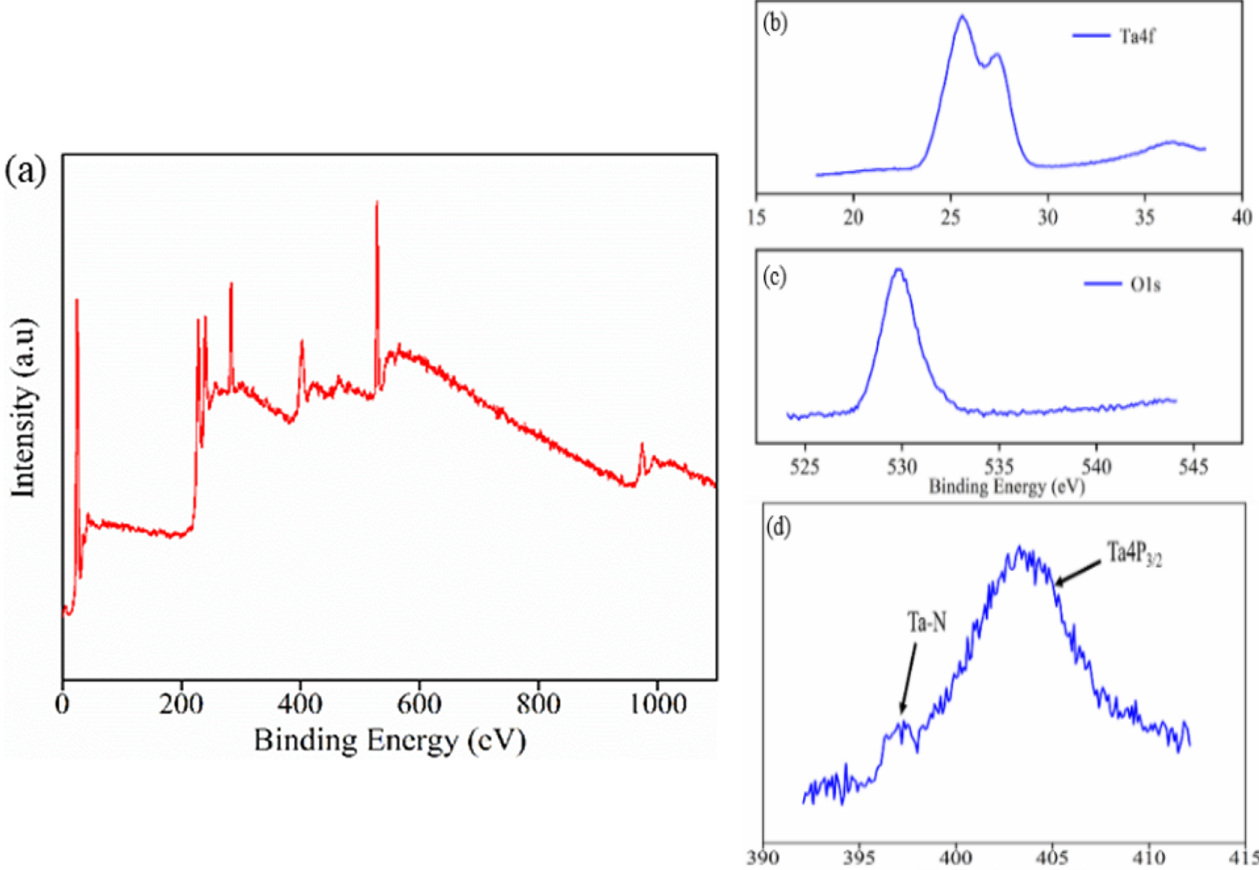
Figure 2. XPS spectra of 34 sccm Ar-6 sccm N 2 and Ta 2 O 5 coatings prepared at a sputtering power of 140 W ( a ): Ta4f ( b ), O1s ( c ), Ta-N and Ta4P 3/2 ( d ).